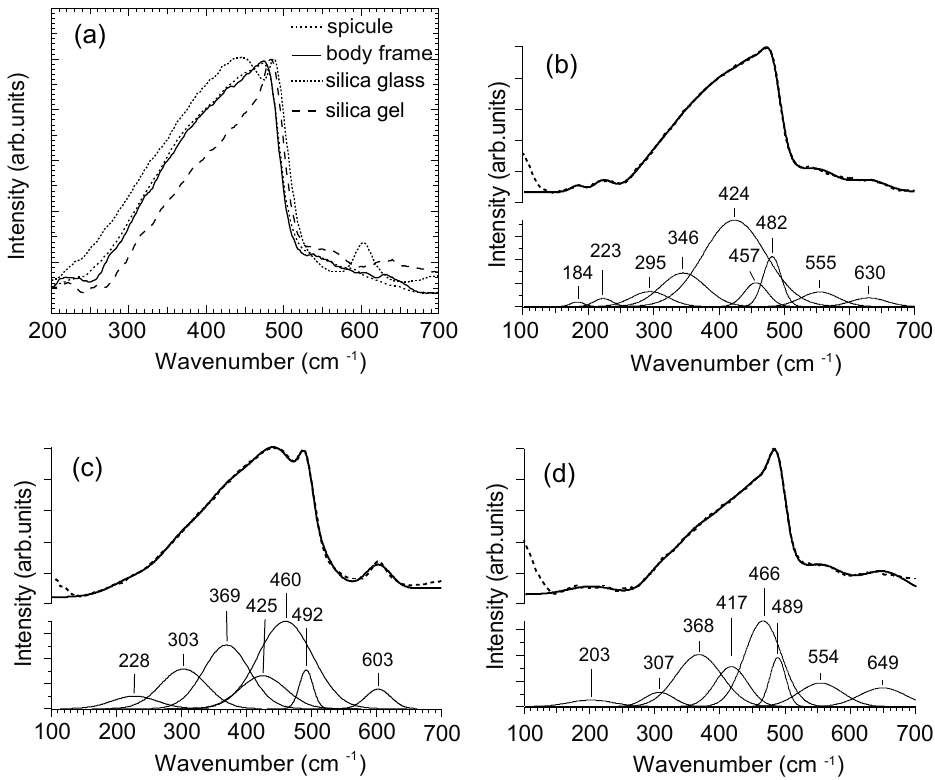
Figure 11. ( a ) Raman spectra ( ν = 200–700 cm − 1 ) for body frame, spicule, silica gel, and silica glass. These spectra were normalized to the D 1 band at ca. ν = 480–490 cm − 1 . The Gaussian peak fitting results for ( b ) body frame, ( c ) silica glass, and ( d ) silica gel. The dashed lines show the measured Raman spectra and the solid lines are Gaussian peak fitting results. Minerals 2018 , 8 , x FOR PEER REVIEW